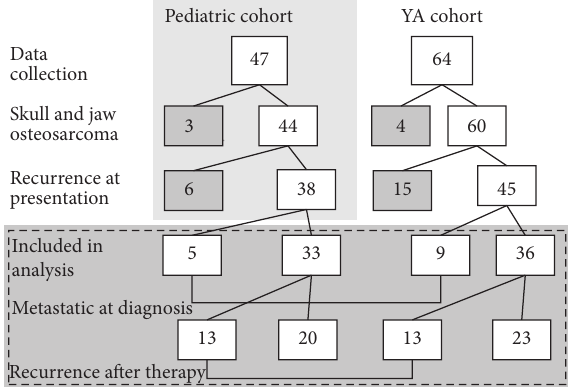
Table 1: Study population